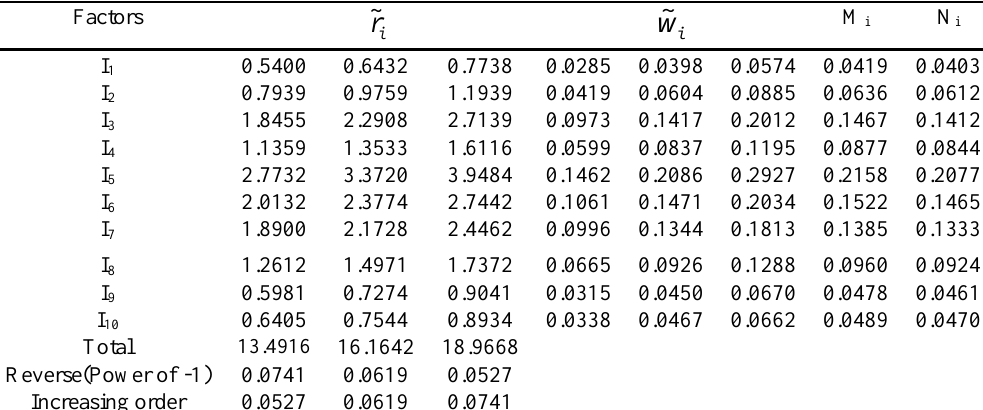
Table 12. Relative non-fuzzy and normalized weights of internal